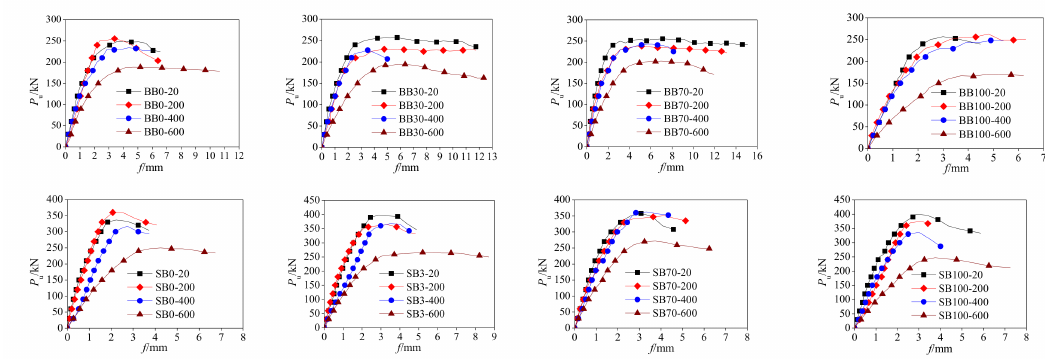
Figure 12. Load–deflection